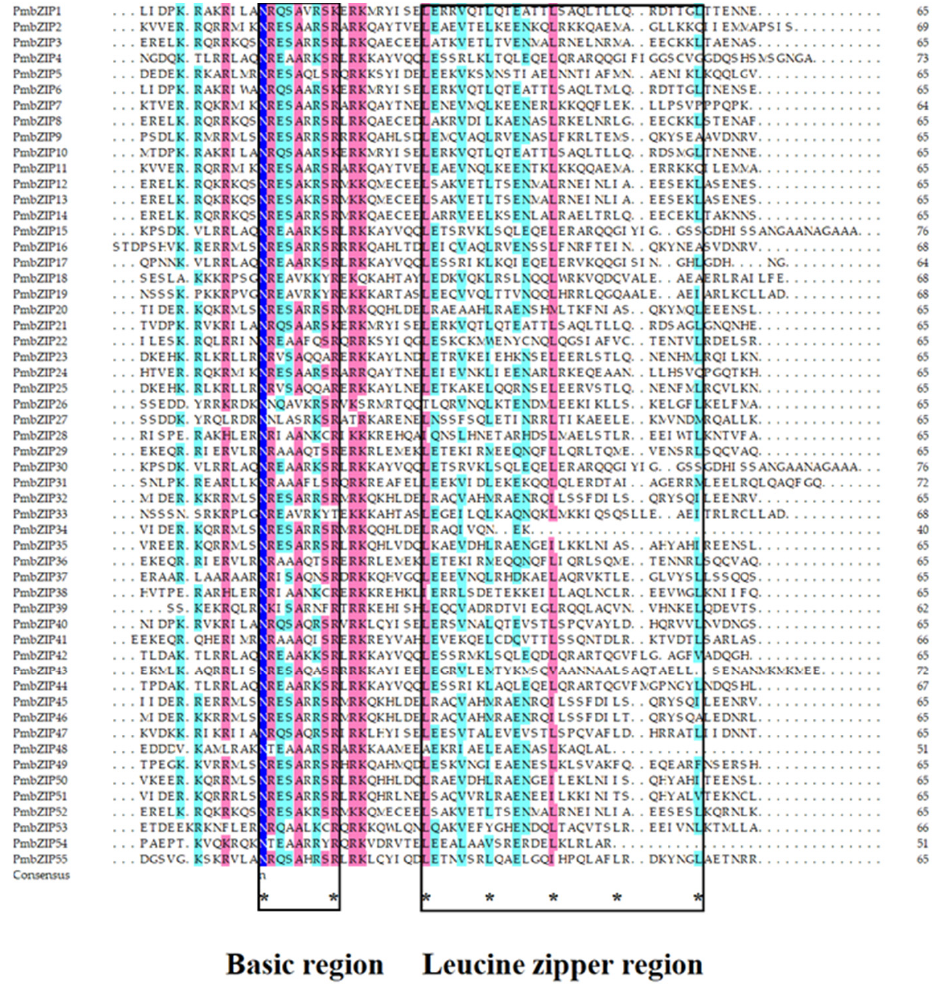
Figure 1. Sequence alignments of conserved domains of all bZIP family proteins in P. massoniana Lamb.. The dark blue, light red, and light blue backgrounds indicate protein identities of 100%, 75%, and 50%, respectively. The basic region and leucine zipper region are marked with black line boxes. The asterisks indicate the conserved amino acids of bZIP